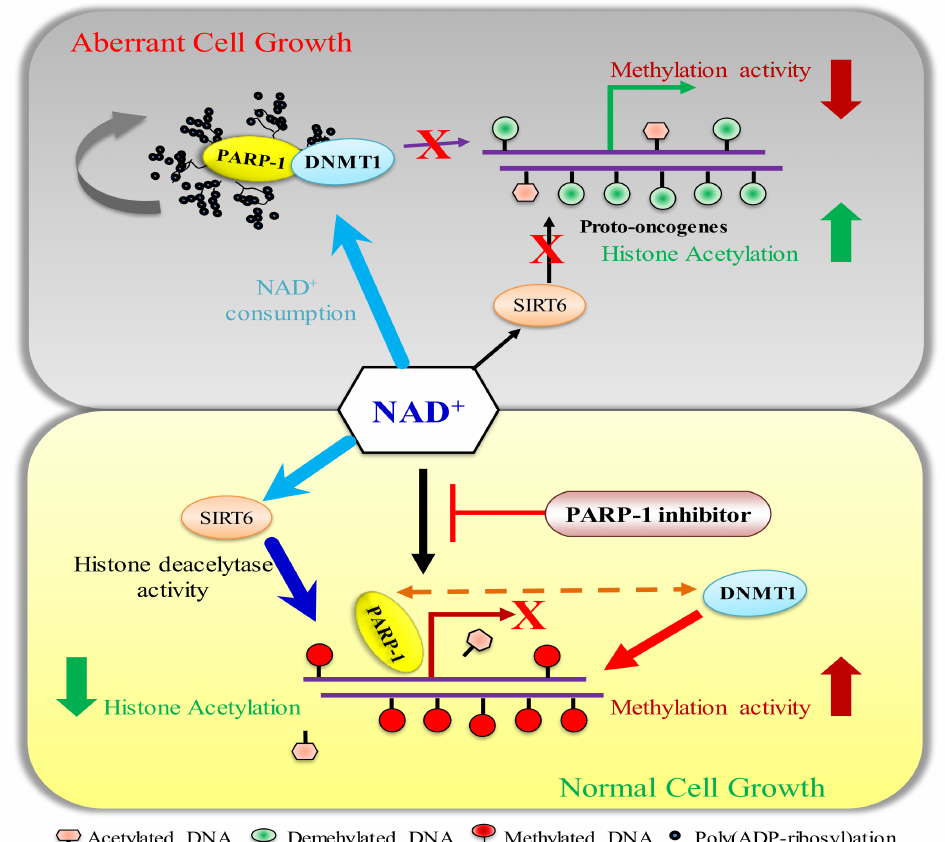
Figure 4. Increased poly(ADP-ribosyl)ation precludes DNMT1 and SIRT6 enzymatic activities. In cancer cells (prostate), the poly(ADP-ribosyl)ation pathway is severely disrupted, resulting in an enhanced activity that not only poly(ADP-ribosyl)ates PARP1 but also DNMT1; therefore, it prevents the maintenance of DNA methylation on newly synthesized DNA strands. Scarcity of NAD + makes SIRT6 enzymatically inactive to remove the acetyl group from histone proteins, eventually facilitating the transcription of oncogenes. The PARP1 inhibitor reverts all activities, which leads to the suppression of